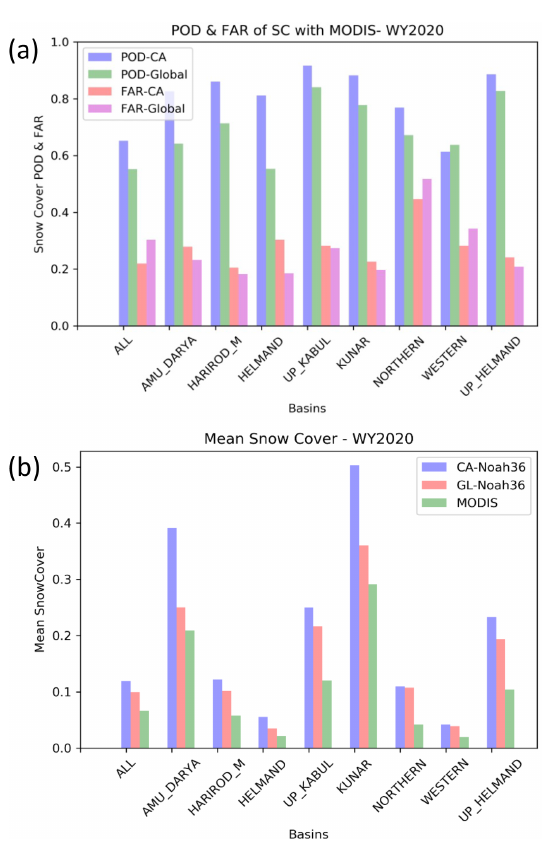
Figure 6. (a) Mean snow cover fraction for the entire area and by hydrologic basin for MODIS Snow Cover Fraction (SCF), Cen- tral Asia (CA), and global (GL) data streams for water year 2020. (b) Probability of detection (POD) of snow presence and false alarm rate (FAR) for the Central Asia (CA) and global data streams rela- tive to the MODIS SCF for water year